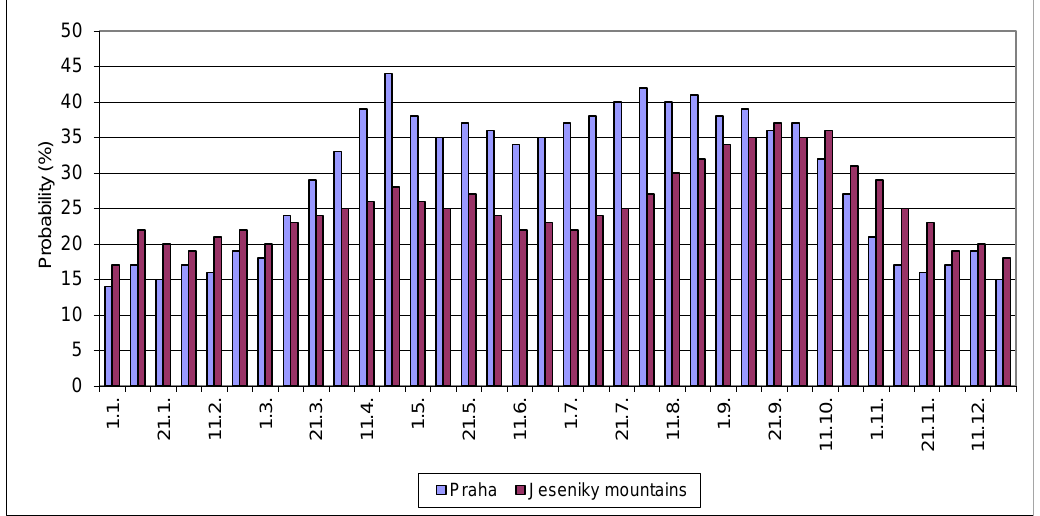
Figure 8. Probability of sunny day occurrence for a given decade for the regions of Prague and the Jeseníky mountains (from SARAH